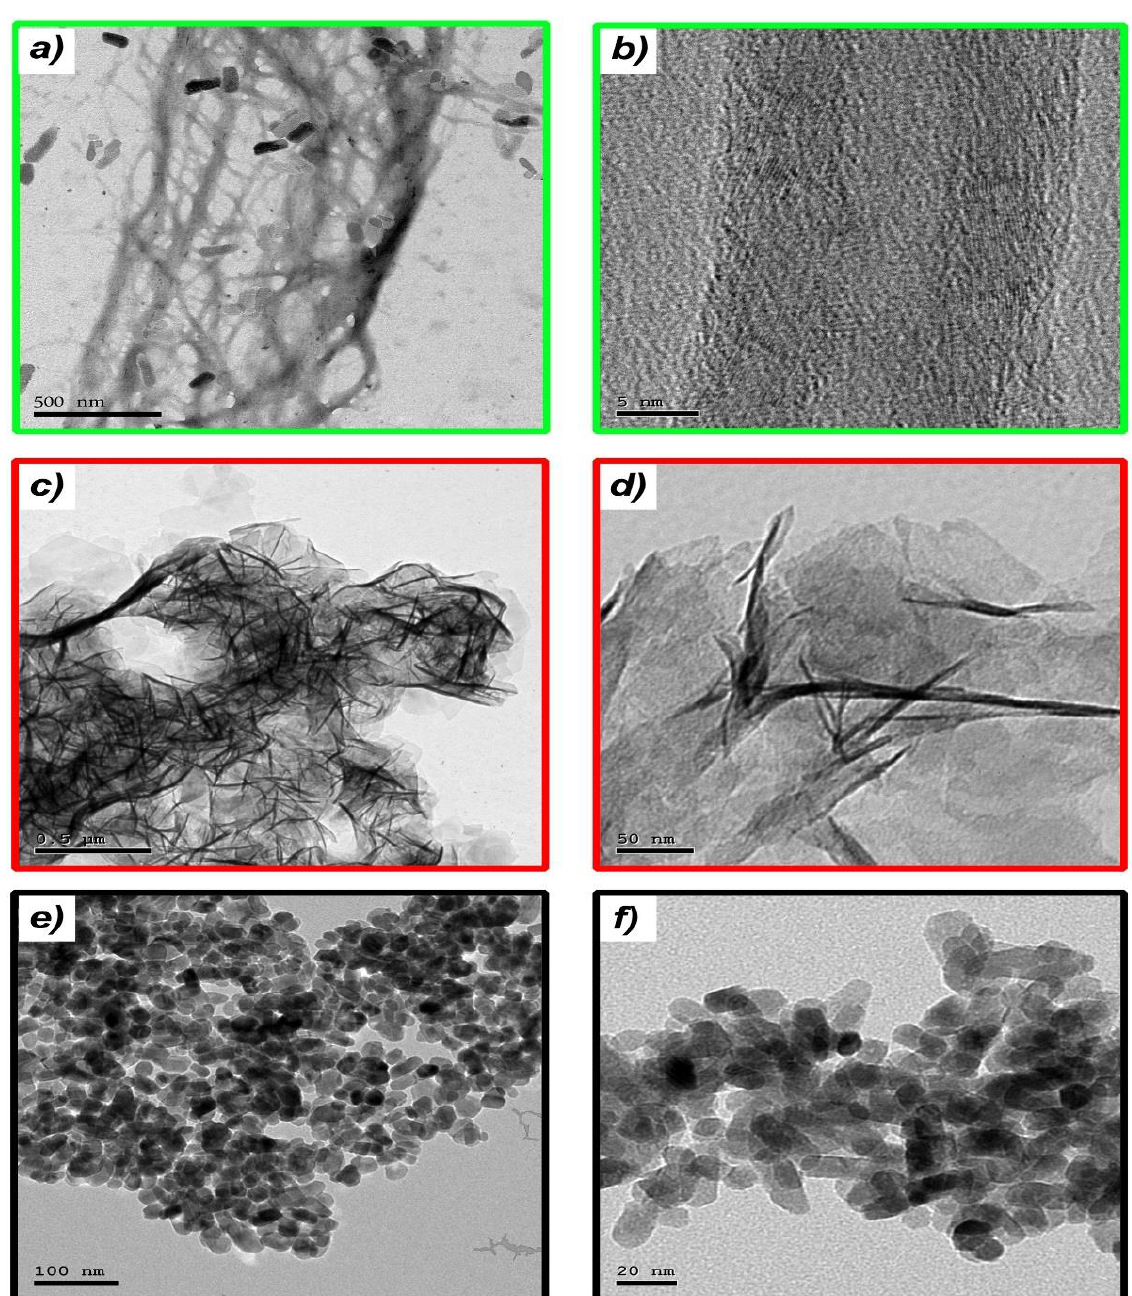
Figure 2. HR-TEM of ( a ) ZnO-MWCNT, ( b ) MWCNT, ( c , d ) GO and ( e , f ) ZnO. Figure 2a represented small Zn-NPs size surrounding MWCNT compared with